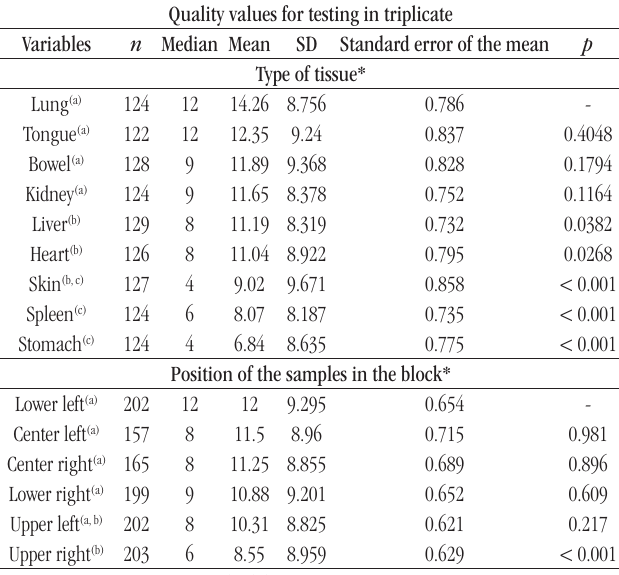
taBLE 2 − Quality of blocks in relation to the type of tissue used to construct the TMA Quality values for testing in triplicate